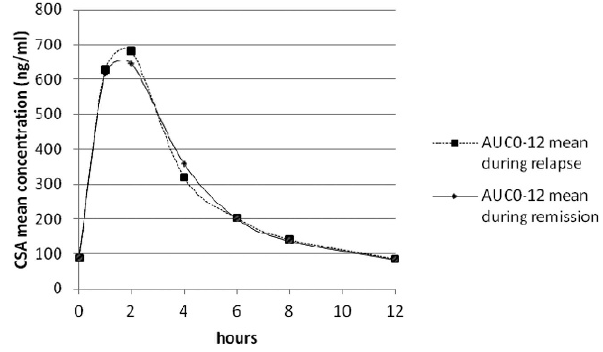
Figure 1 - AUC0-12 during remission and relapse of INS.